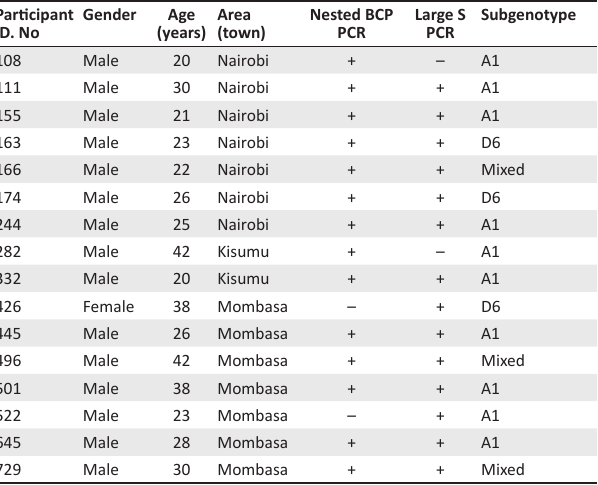
associated with HBV infection (Table 3).